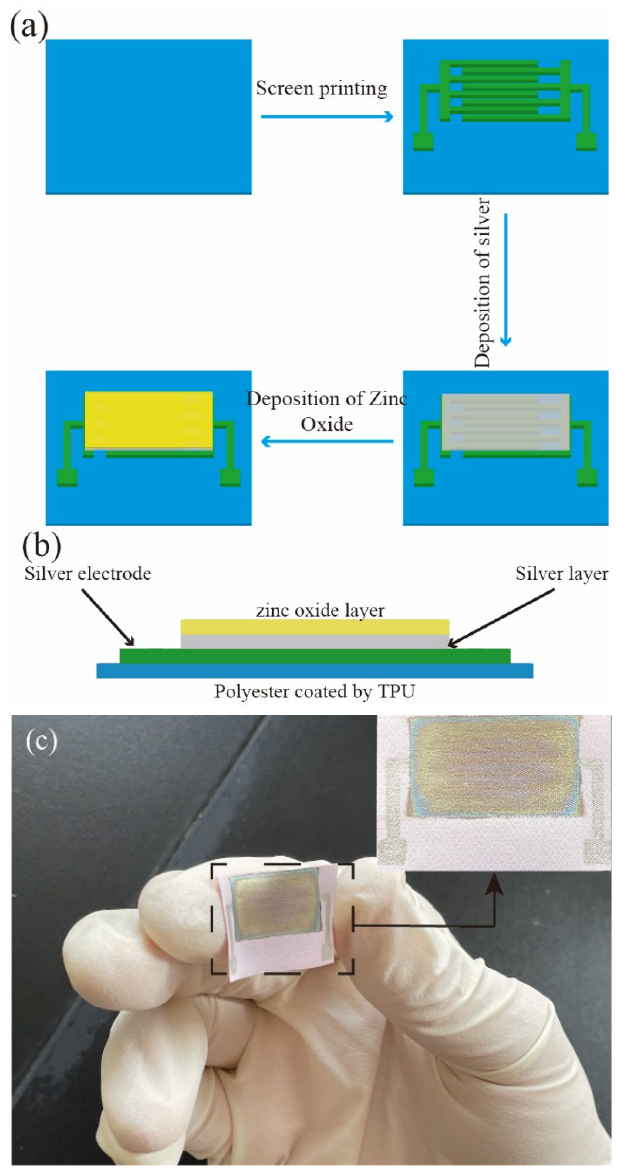
Figure 3. ( a ) Schematic diagram of flexible temperature sensor fabrication process; ( b ) Cross section schematic diagram of flexible temperature sensor; ( c ) Picture of flexible temperature sensor.